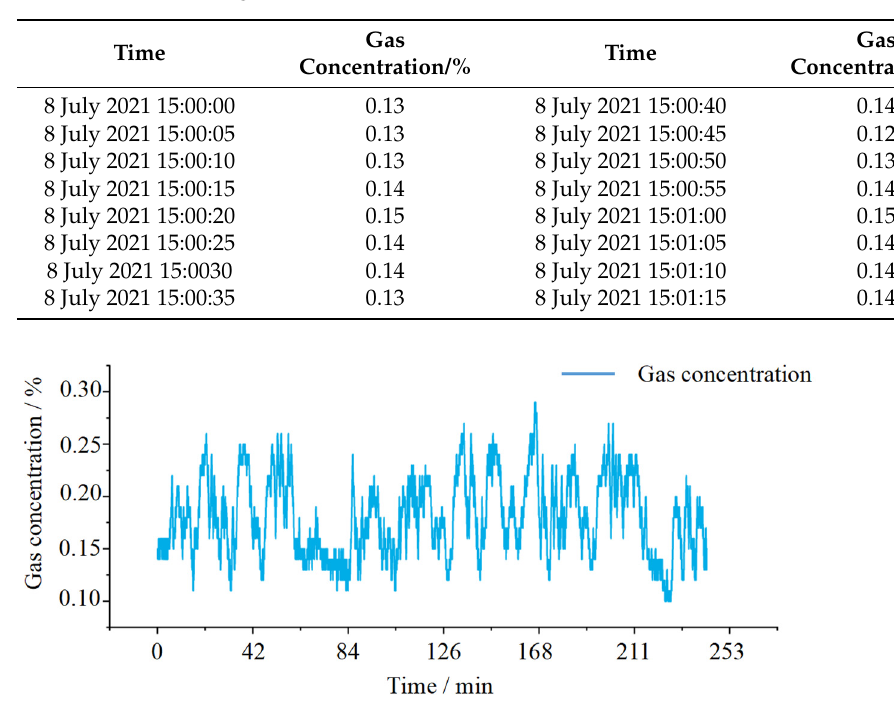
Table 1. Part of the original data record.